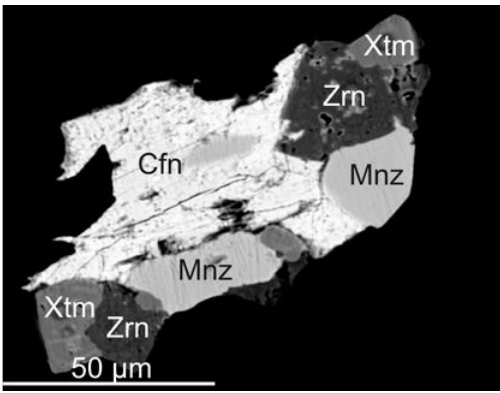
Figure 6. High-contrast back-scattered electron (BSE) image of complex intergrowths of coffinite (Cfn), zircon (Zrn), monazite (Mnz), and xenotime (Xtm) from high-F, high-P 2 O 5 Li-mica granite, Hub stock.